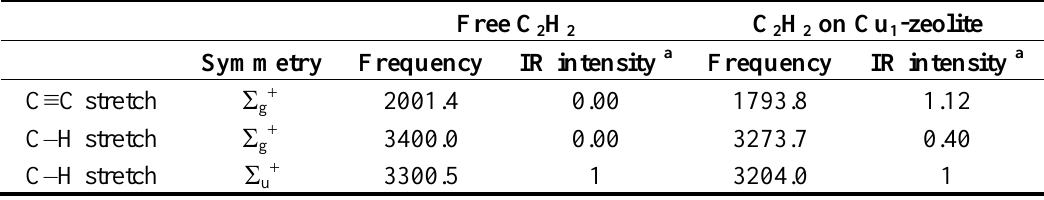
Table 1. Calculated vibrational frequencies (cm -1 ) of CC and CH stretching modes of C before and after the binding into the small monocopper zeolite model.